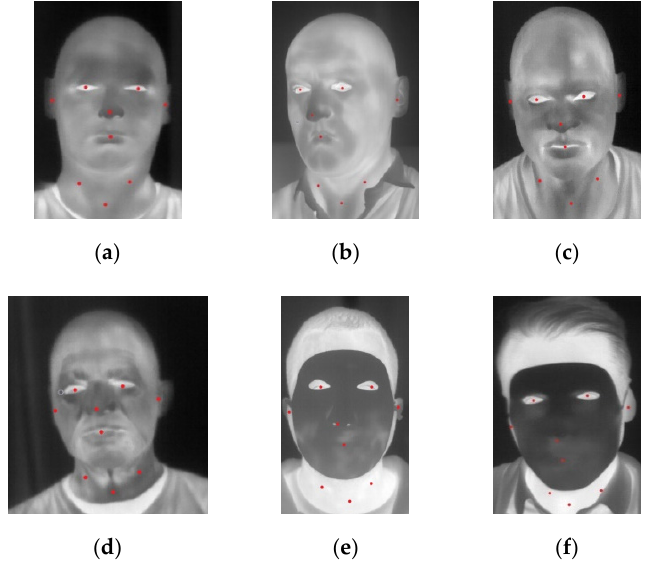
Figure 4. Annotated thermal images presenting the subject wearing ( a , b ) flexible latex masks acquired using a high-end camera, ( c , d ) flexible latex masks acquired using a low-cost camera and ( e , f ) 3D-printed mask acquired using a high-end camera. All images annotated, indicating analyzed landmarks.